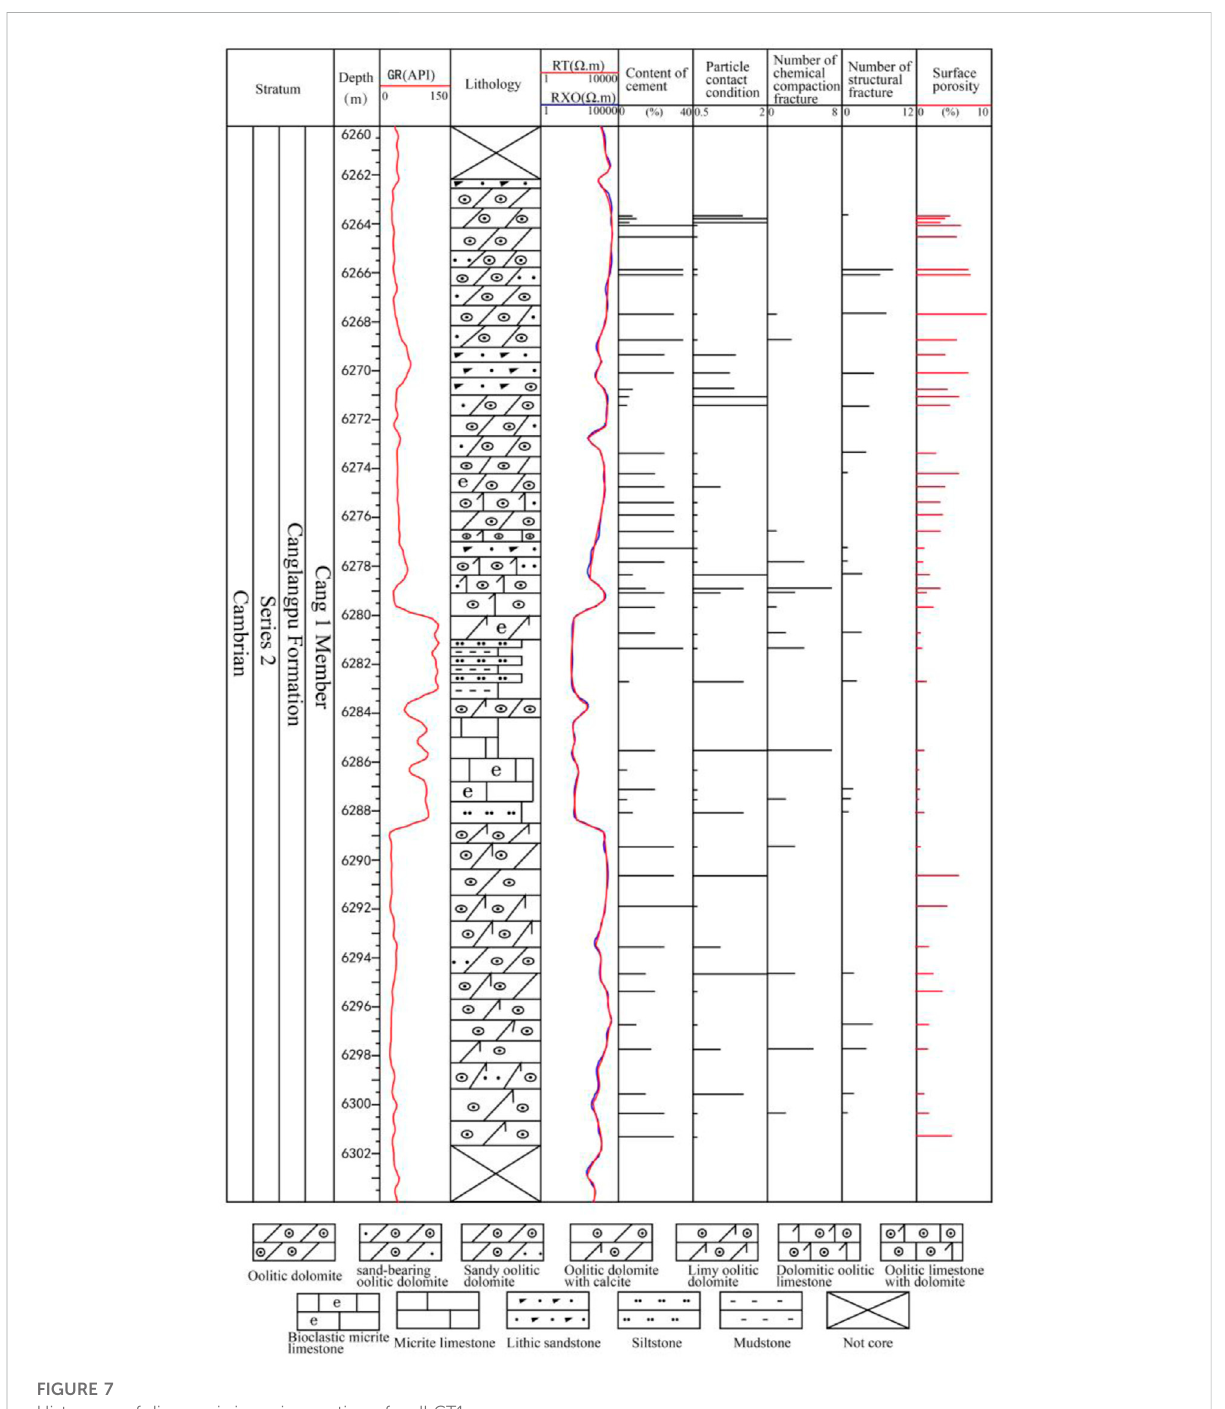
FIGURE 7 Histogram of diagenesis in coring section of well